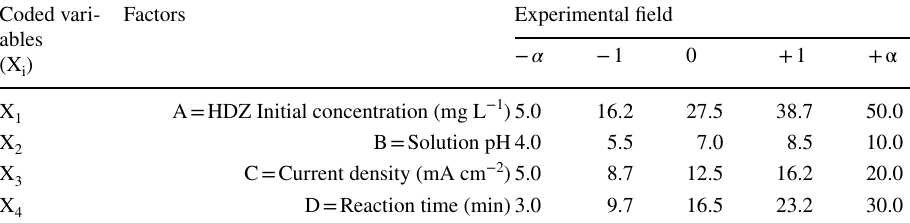
Table 1 Experimental level of the independent variables in the treatment process